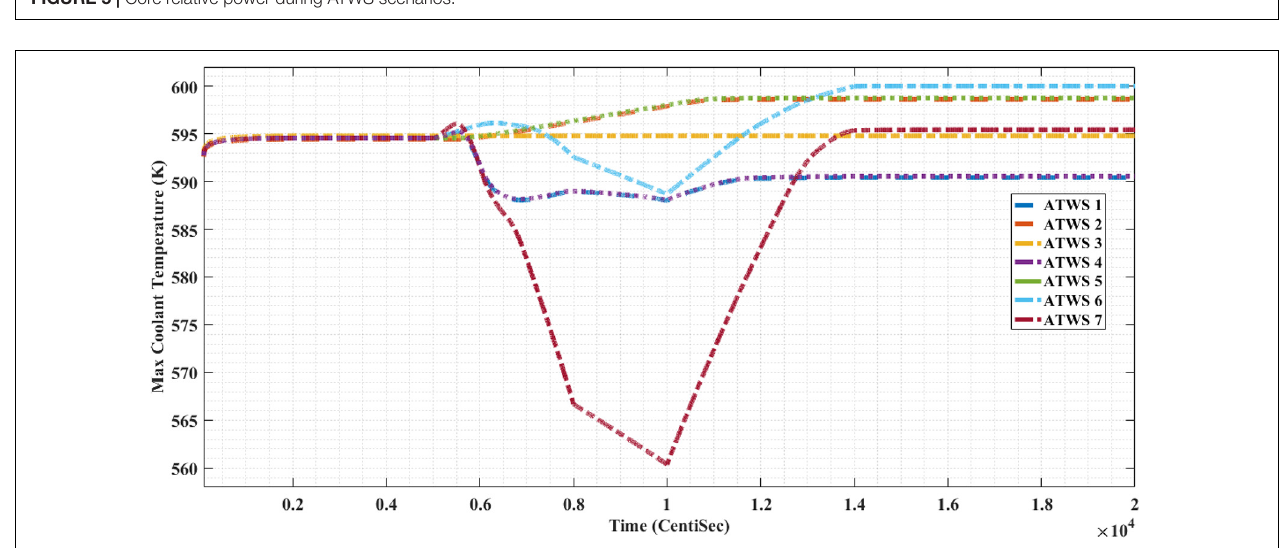
FIGURE 6 | Maximum coolant temperature during ATWS